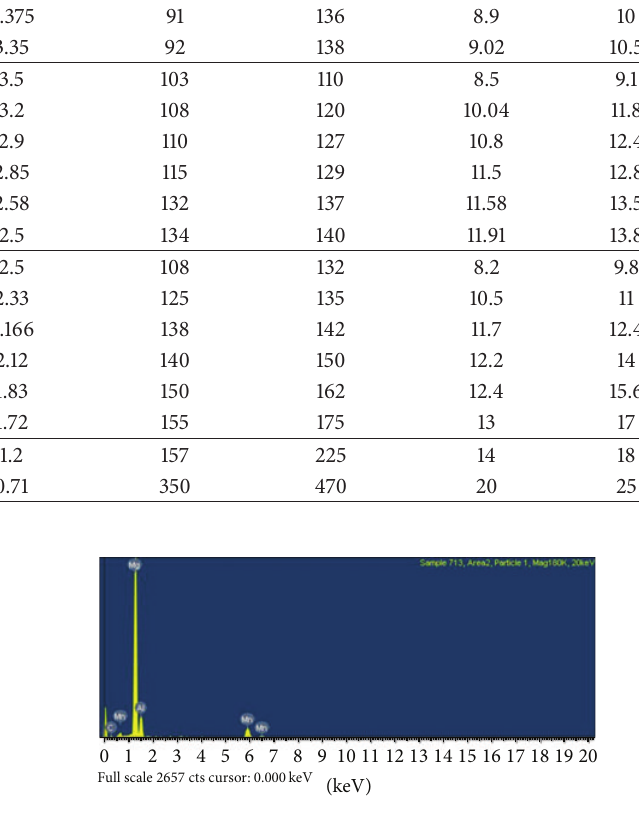
Figure 9: EDX analyses of point 2 of Figure 8.